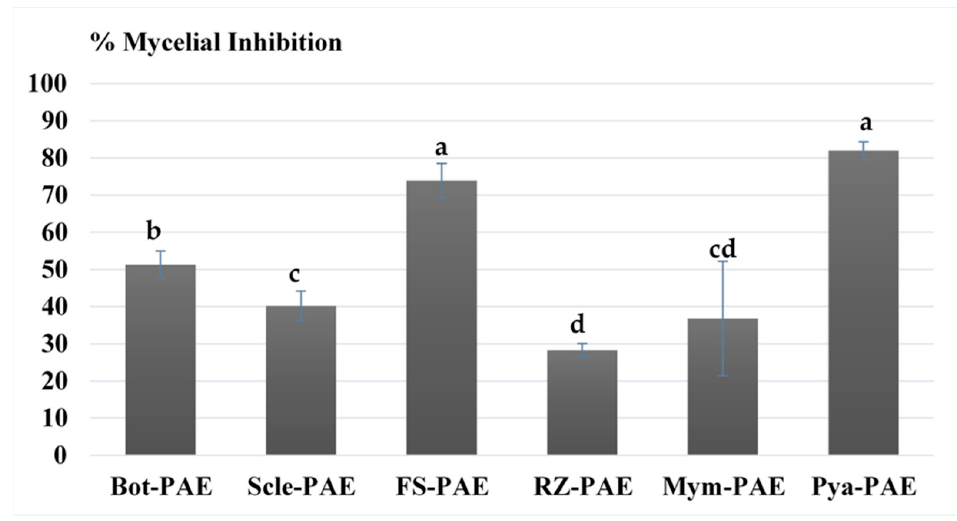
Figure 3. Antagonistic effects of Paecilomyces variotii (PAE) on Botrytis cinerea (Bot), Sclerotinia sclerotiorum (Scle), Fusarium solani (FS), Pythium aphanidermatum (Pya), Rhizoctonia solani (Rz), and Mycosphaerella melonis (Mym) in dual culture on PDA medium. Percent mycelial inhibition was calculated as PIRM = ((R1 − R2)/R1) × 100, where PIRM is the percentage of inhibition of radial mycelia growth of the pathogen. R1 is radial growth of the pathogen in control plates, and R2 is radial growth of the pathogen in dual cultures. Means with the same letter are not significantly different (least significant difference test) according to an analysis of variance ( p > 0.05).